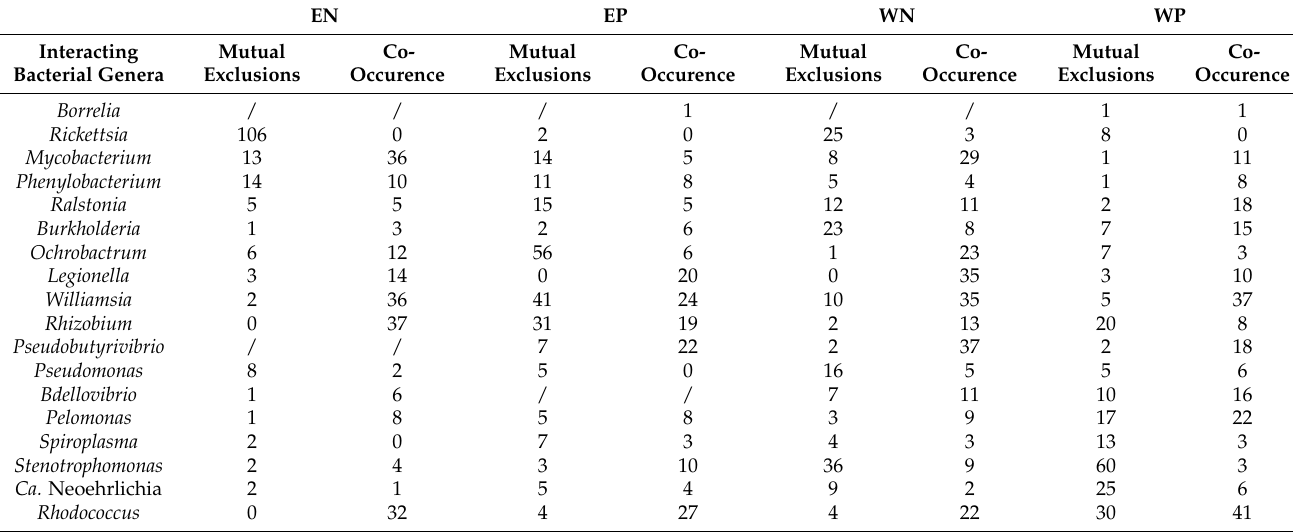
Table 1. Overview of interaction patterns of bacterial genera with important topological roles from the tick-borne Borrelia -negative (EN; WN) and Borrelia -positive (EP; WP) co-occurrence networks obtained from Esslingen (E) and Weiden (W), respectively. The EN, WN, EP, and WP networks were composed of 62, 56, 38, and 44 bacterial community assemblages, respectively. EN EP WN WP Interacting Bacterial Genera